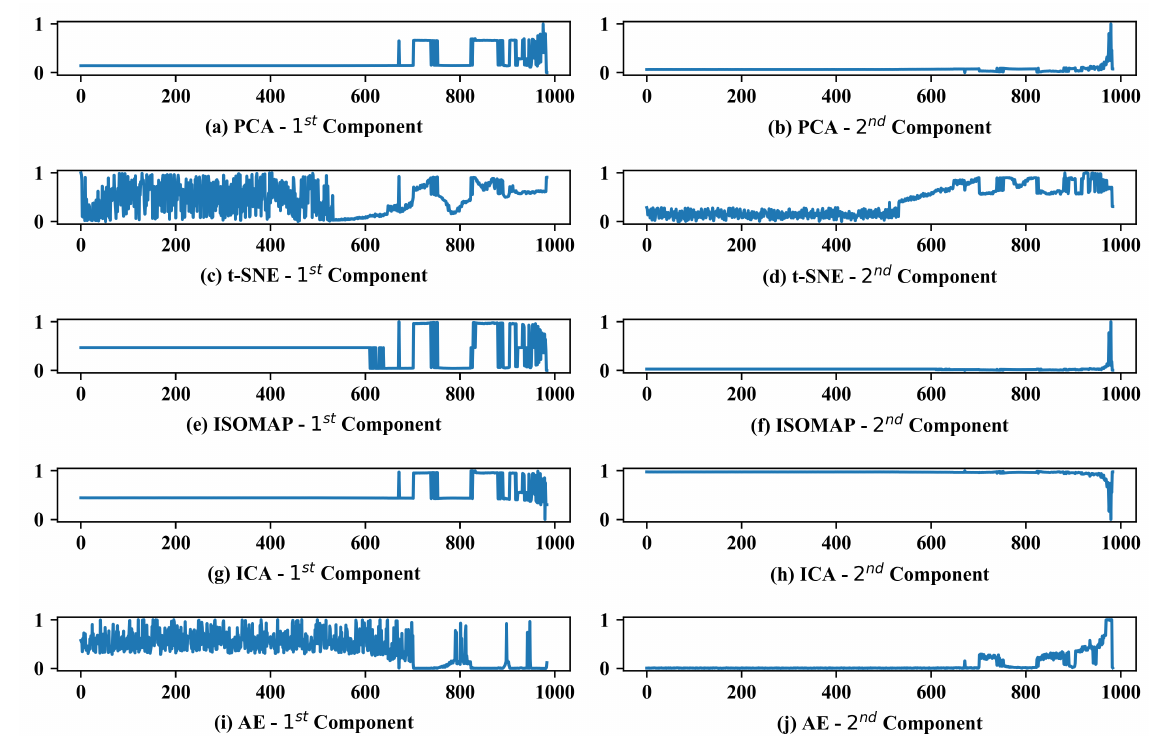
Figure 9. Reduced dimensionality of extracted features using different